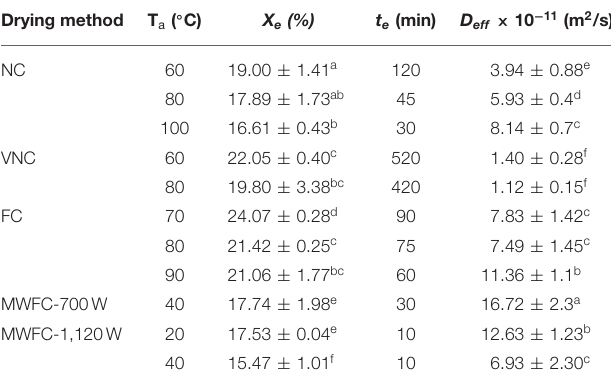
TABLE 1 | Drying times, equilibrium moisture content, equilibrium time, and diffusivity coefficient obtained in each drying method. Drying method T a ( ◦ C)